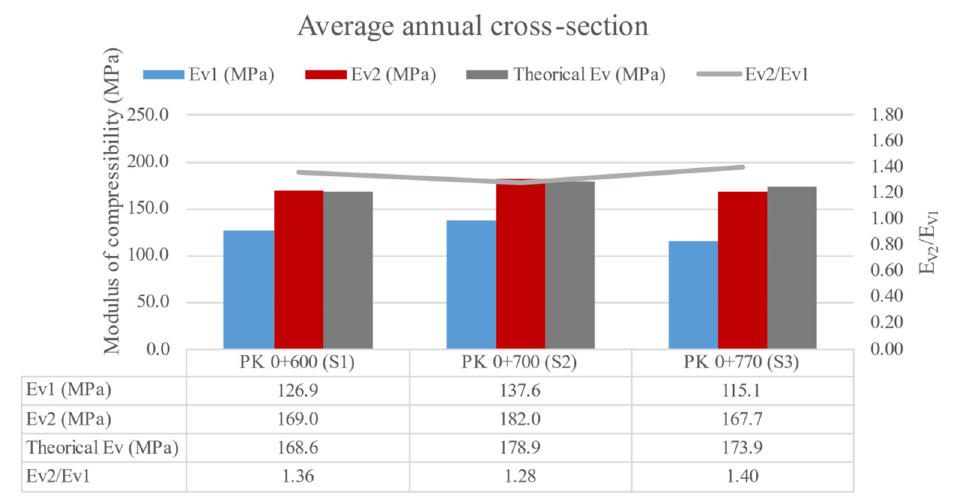
Figure 17. Annual average plate bearing test results.